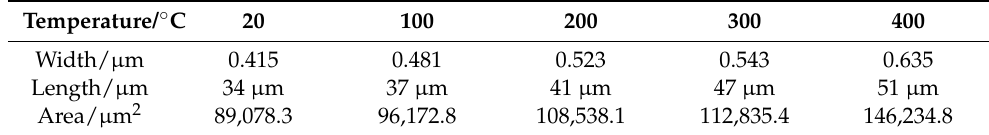
Figure 4. EDS of worn surface and EDS of oxygen distribution of 20~400 °C in group 1: ( a , b ) 20 °C; Table 4. Friction coefficient and wear depth of 316L stainless steel in group 1.